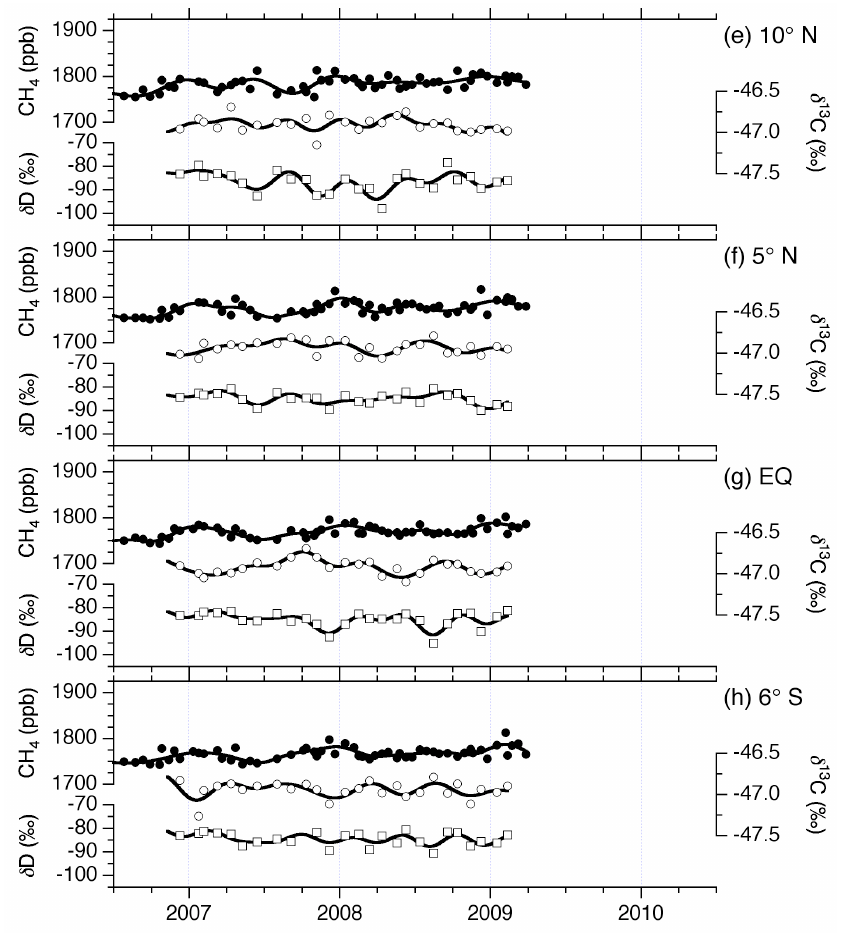
Fig. 2. Same as Fig. 2a–d, but for (e) 10 ◦ N, (f) 5 ◦ N, (g) the equator and (h) 6 ◦ S between Australia and